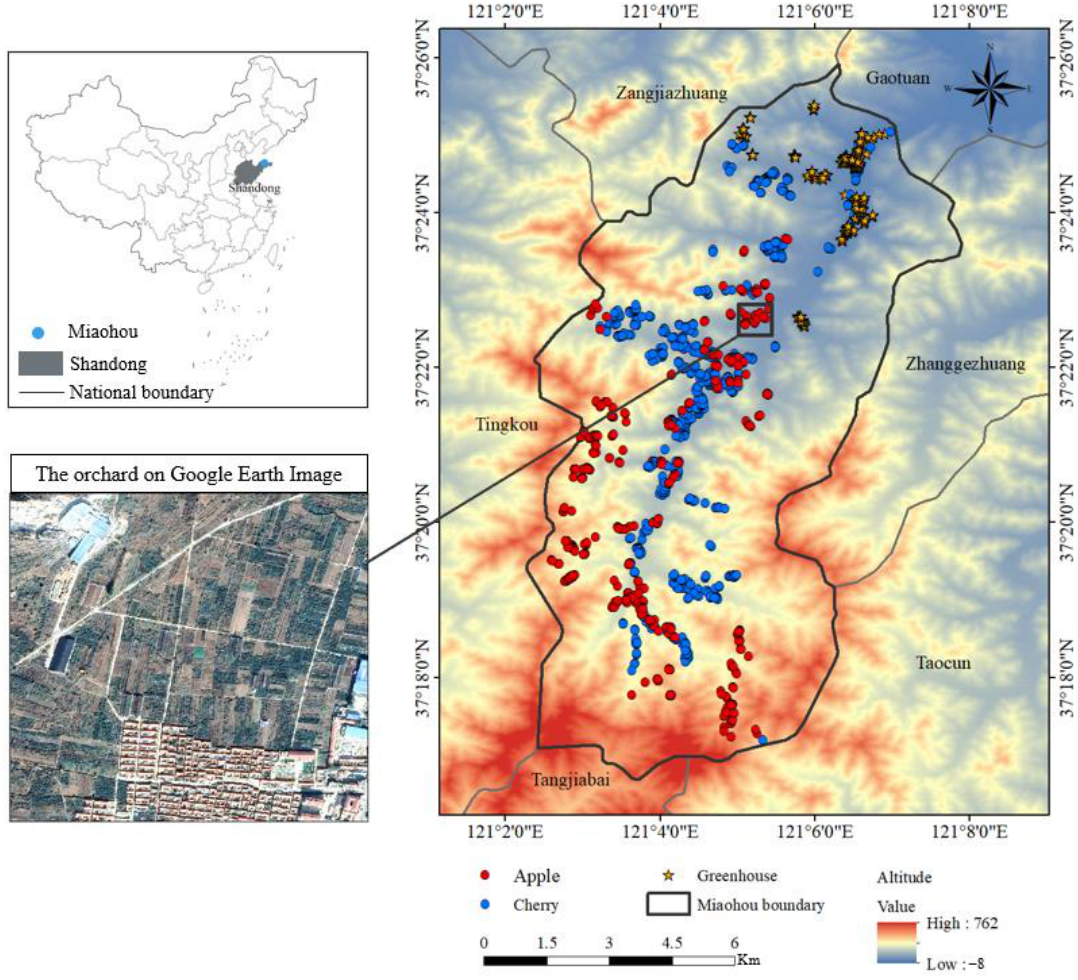
Figure 1. The location of the study area.